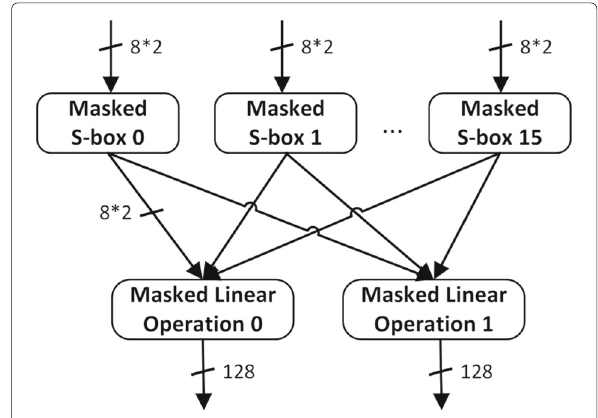
Fig. 3 The process of existing first-order masking scheme in one AES round